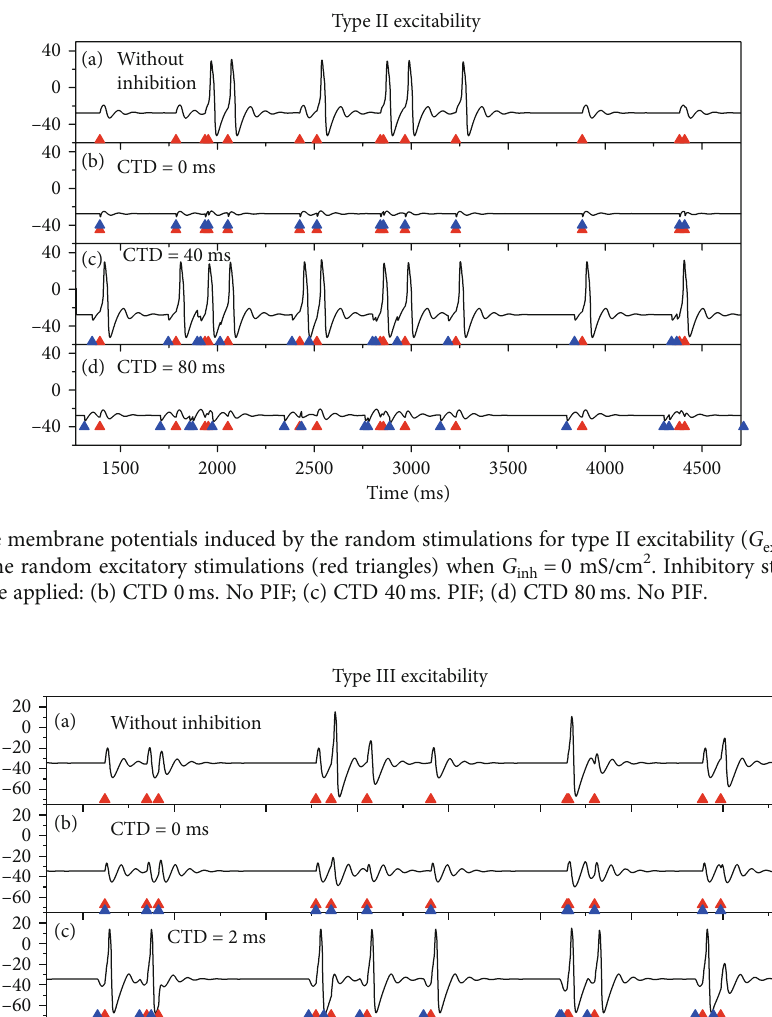
Figure 7: The membrane potentials evoked by the random stimulation for type III excitability ( G excitatory stimulations (red triangles) with G inh = 0 : 5 mS/cm 2 can evoke action potentials when G inh = 0 mS/cm 2 . Inhibitory stimulations (blue triangles) are applied: (b) CTD 0 ms. No PIF; (c) CTD 2ms. PIF; (d) CTD 5 ms. No